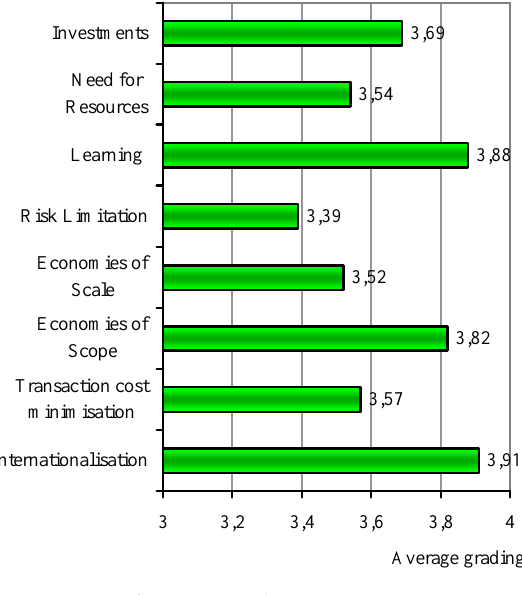
Fig 2. Motives for cooperation